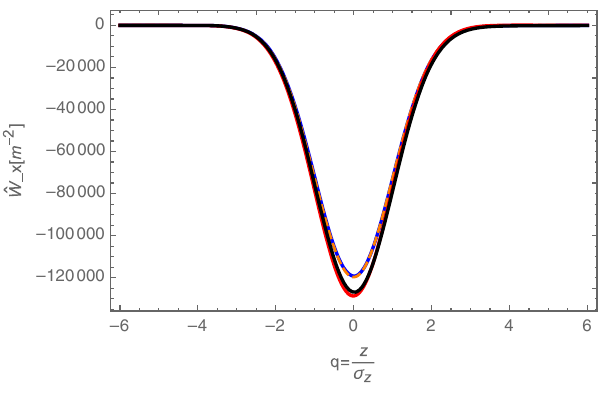
FIG. 6. The horizontal wakes at various horizontal positions: χ ¼ − σ = ρ (in black color), 0 (blue), and σ x comparison to the Gaussian profile (dashed orange) in Eq. (39) with Λ ¼ 3